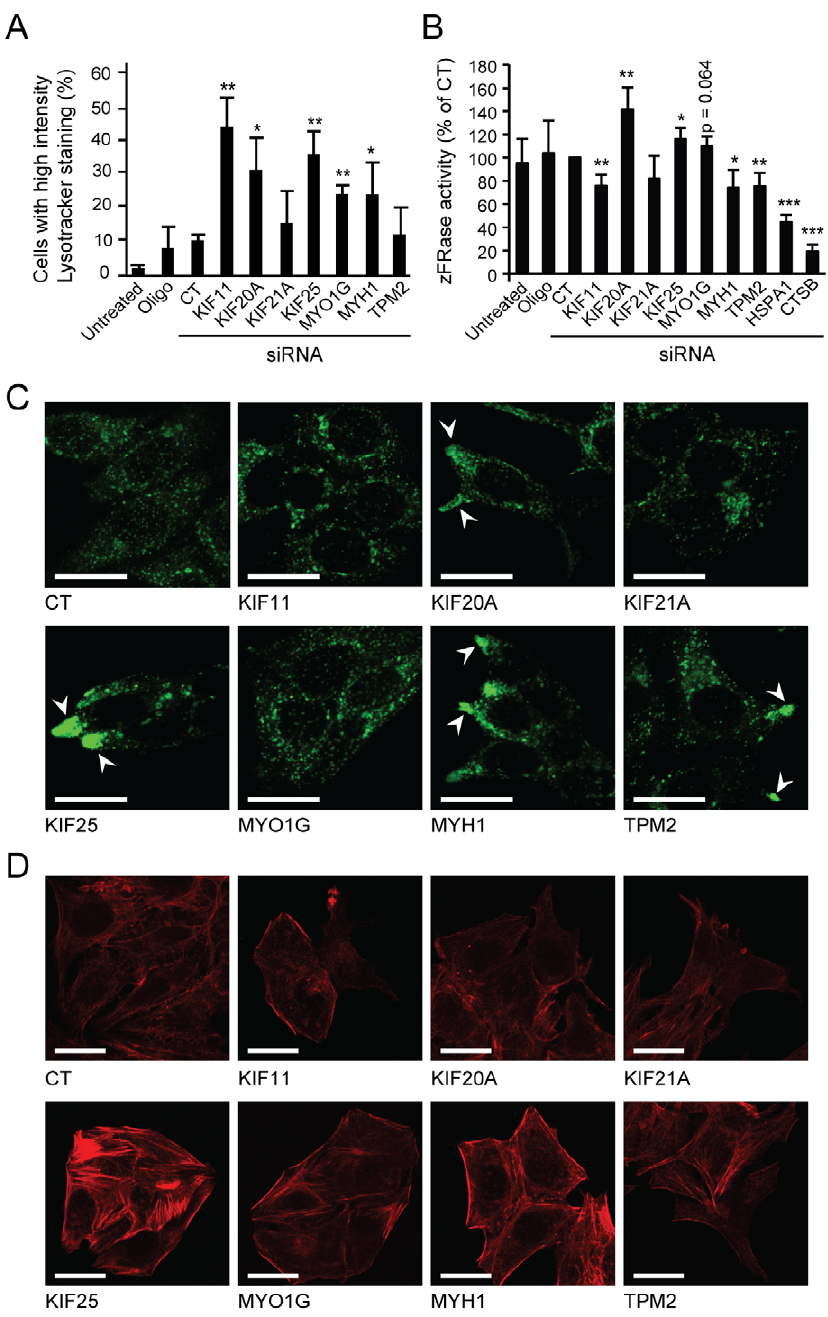
Figure 2. Effect of the identified siRNAs on lysosomes and cytoskeleton. (A–D) MCF7 cells were left untreated, treated with Oligofectamine (Oligo) or transfected with control siRNA (CT) or indicated siRNA pools. (A) After 60 h, cells with enlarged acidic compartment (late endosomes and lysosomes) were identified by flow cytometry (FL-2A) of LysoTracker Red-stained cells. The threshold for high intensity staining was defined so that 90% of control siRNA-transfected cells were below. (B) After 72 h, total cysteine cathepsin activity (zFR-AFC cleavage) was determined. HSPA1 and CTSB siRNAs served as internal controls. (C, D) After 60 h, cells were stained for Lamp-2 (C) or F-actin (D) and analyzed by confocal microscopy. Representative images are shown. Arrows , aggregation of lysosomal structures in cell protrusions/periphery. Bars , 20 m m. Values represent means + SD of a minimum of three independent experiments. * P , 0.05, ** P , 0.01, *** P , 0.001, vs. control siRNA-transfected cells.